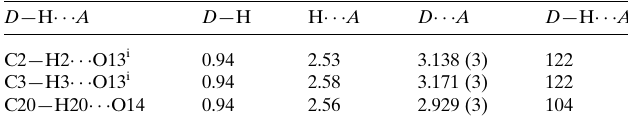
Table 1 Hydrogen-bond geometry (A˚ , (cid:2) ).